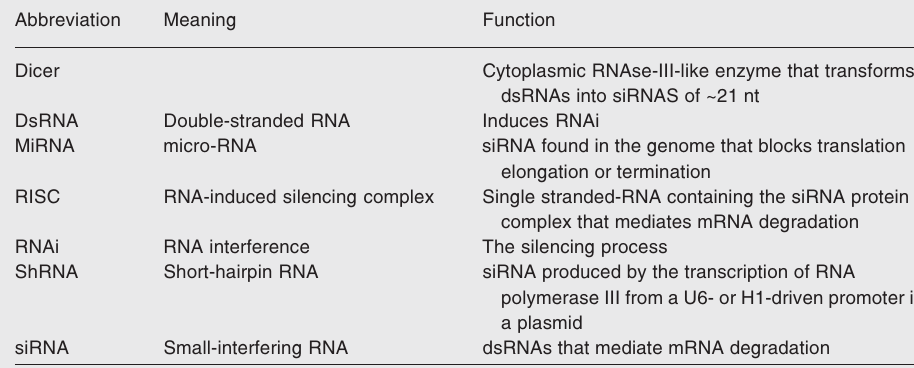
Table 1. RNA interference